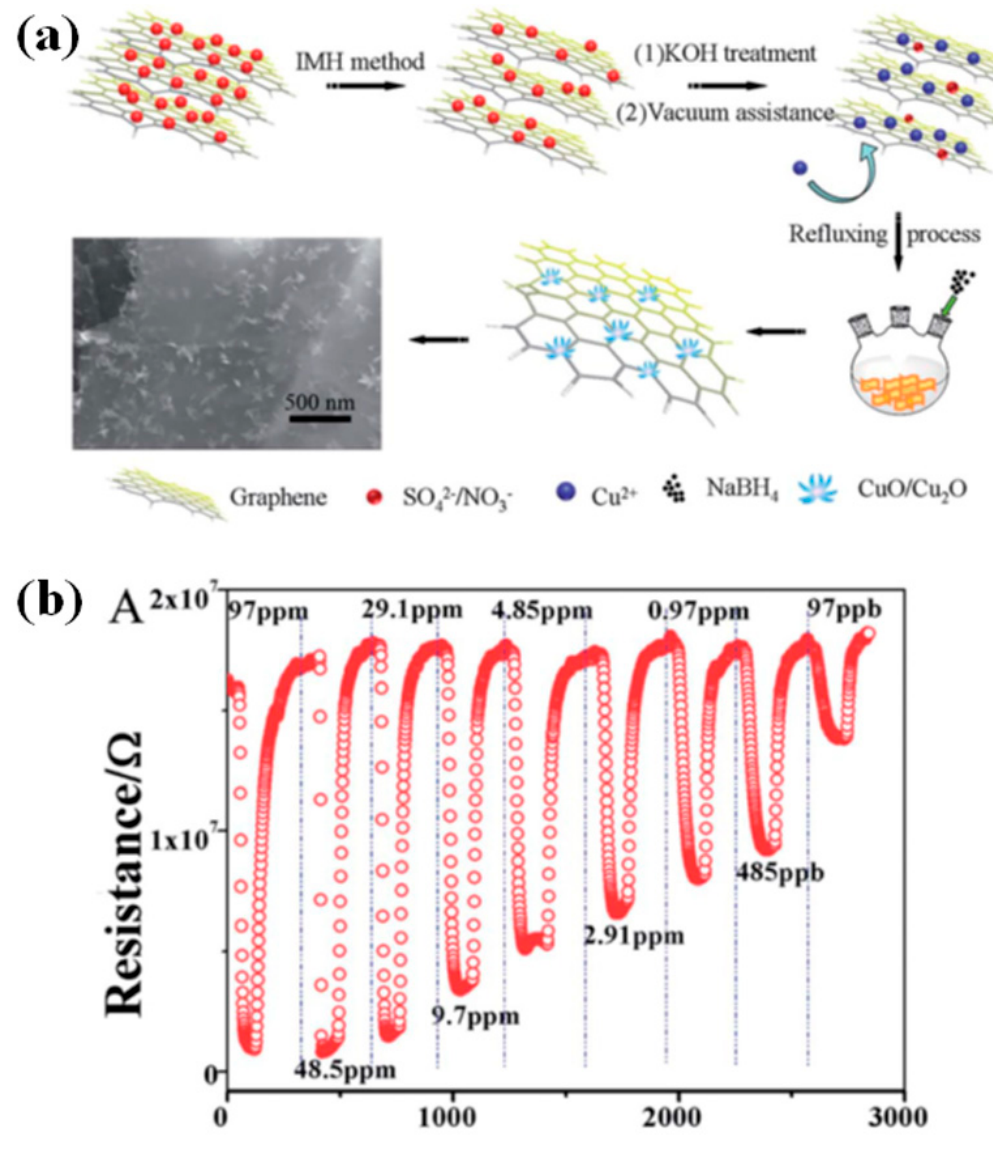
Figure 10. ( a ) Schematic illustration of formation of 3D nanoflower-like CuxO/multilayer graphene; ( b ) Dynamic sensing property of CuMGC at room temperature. Reproduced with permission from [92] © 2014 Royal Society of